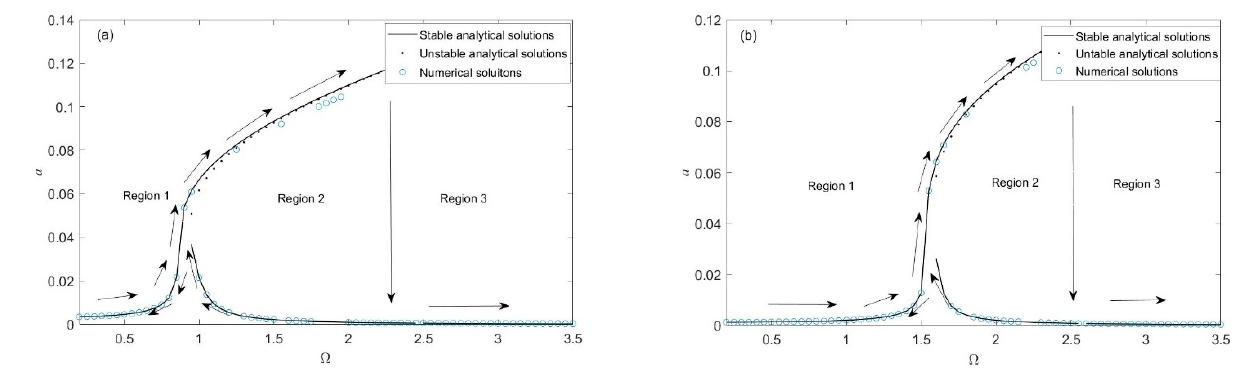
Figure 3. Frequency–amplitude response of the SMA oscillator system (11): h = 0, ζ = 0.1, β = − 1.3 × 10 3 , γ = 4.7 × 10 5 , f = 0.03. “-” stable analytical solutions, “.”unstable analytical solutions, “o” numerical solutions. ( a ) θ = 1.9; ( b ) θ = 3.5.